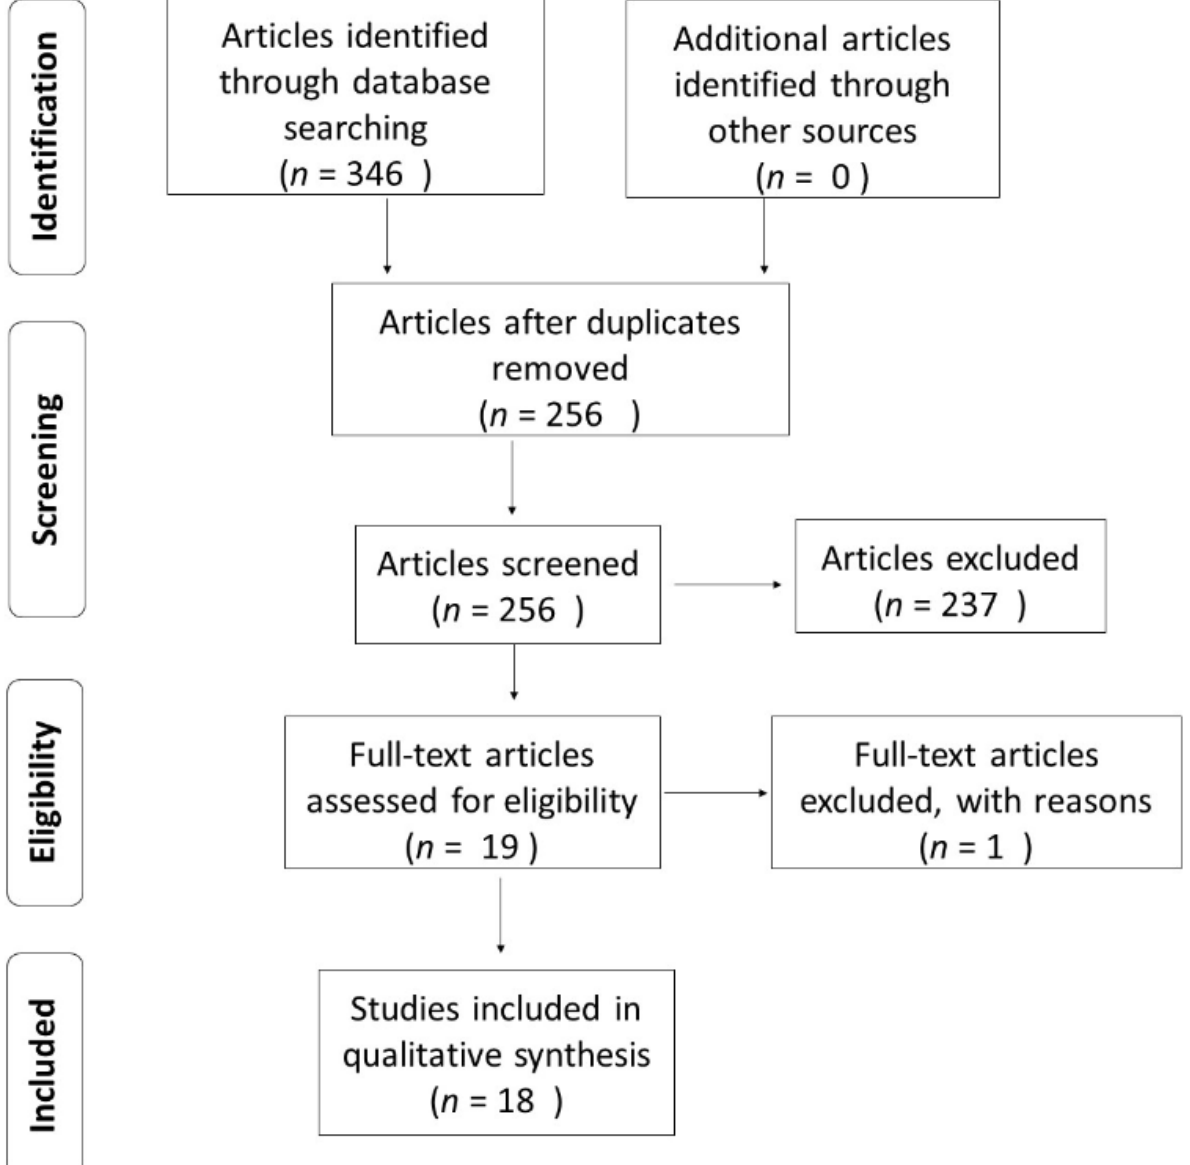
Figure 1. Flowchart of article selection. São José-SC—Brazil, 2021.